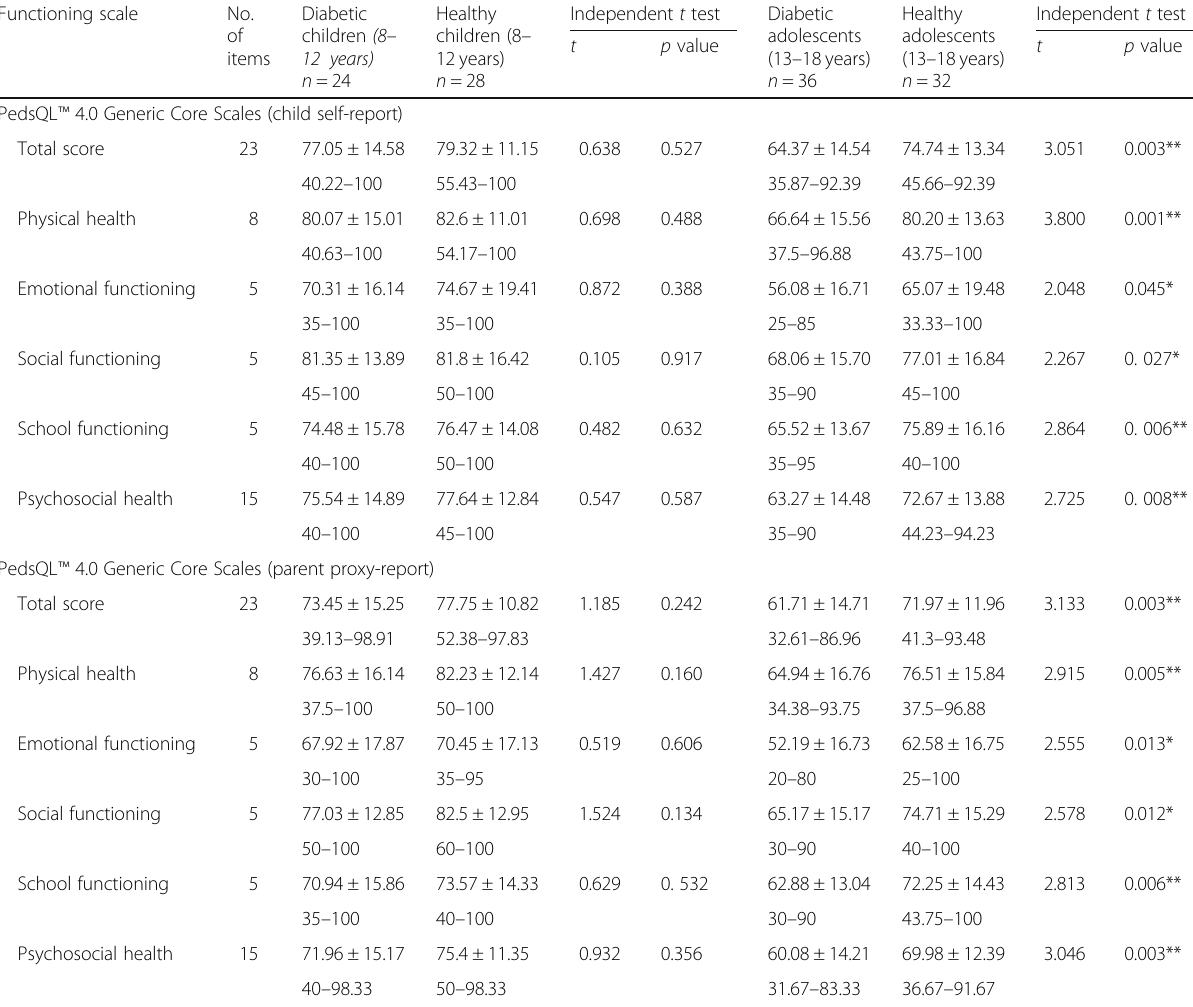
Table 3 Comparison between the studied diabetic children (8 – 12 years) and adolescents (13 – 18 years) with their corresponding control groups concerning their child self-reports and parent proxy-reports of PedsQL ™ 4.0 Generic Core Scales (GCS) scores Functioning